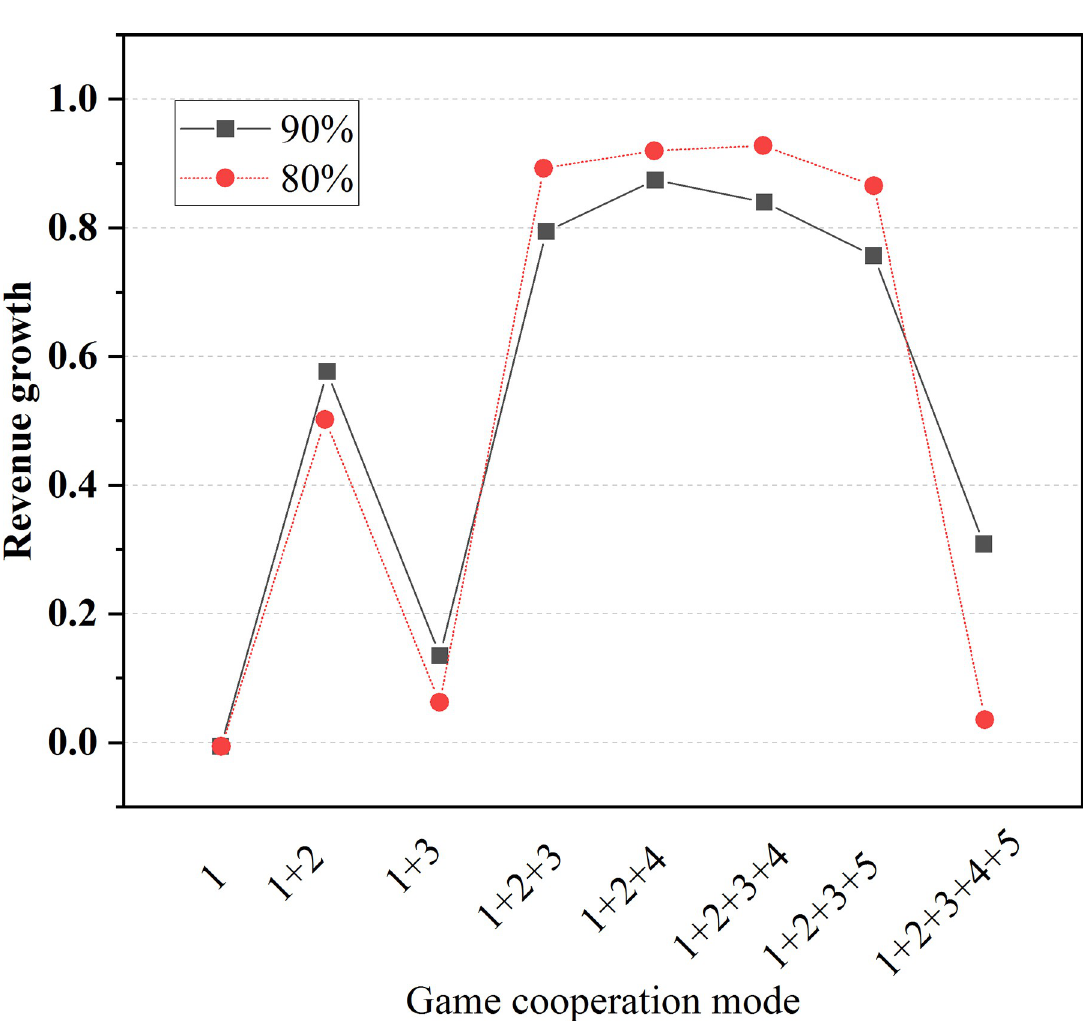
Fig 14. Trend of total benefit under different game combinations